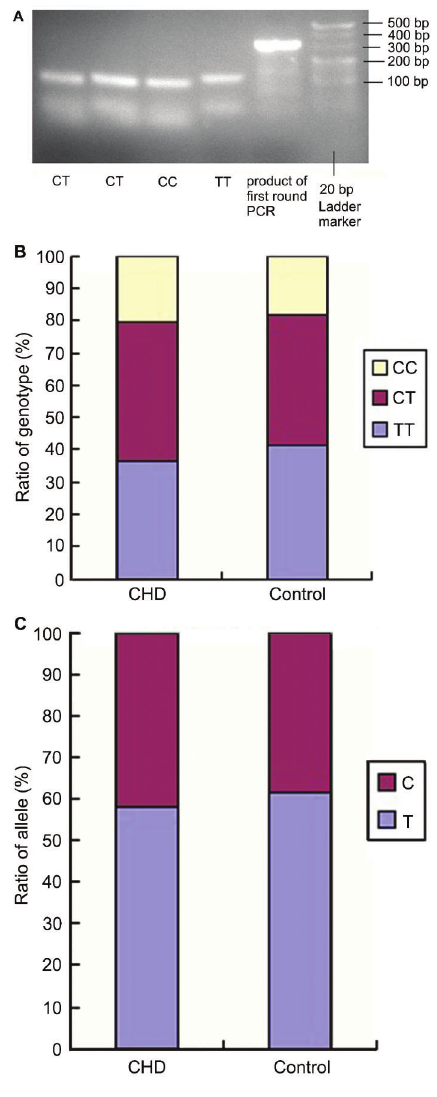
Figure3. Distributionofgenotypesandallelesofrs3173798 between coronary artery heart disease(CHD)patients and healthy controls. A , There are three genotypes of rs3173798 in the chipping fragments displayed by RFLP analysis: TT (121 bp), CC (102++19 bp) and CT (121++102++19 bp) in theory, but, the molecule of 19 bp was so small that the band of electrophoresis was too weak to observe, and the molecule of 121 and 102 bp were too close that the bands of electrophoresis were not easily to distinguished. Thus, CC genotype had only one band of 102 bp, and CT genotype had a thick and bright band of the combination of 121 and 102 bp. B , Frequencies of the three genotypes (TT, CT, CC) of rs3173798 in the CHD group and control group were 36.61, 42.86, 20.53%, and 41.54, 40.00, 18.46%, respectively. There was no significant difference in distribution of genotypes between the two groups (P=0.732). C , Frequencies of C/ T alleles of rs3173798 in the CHD group and control group were 58.04, 41.96, and 61.54, 38.46%, respectively. No significant difference in the distributions of C/T allele frequencies was observed between the two groups (P=0.433). The x 2 test was used for statistical